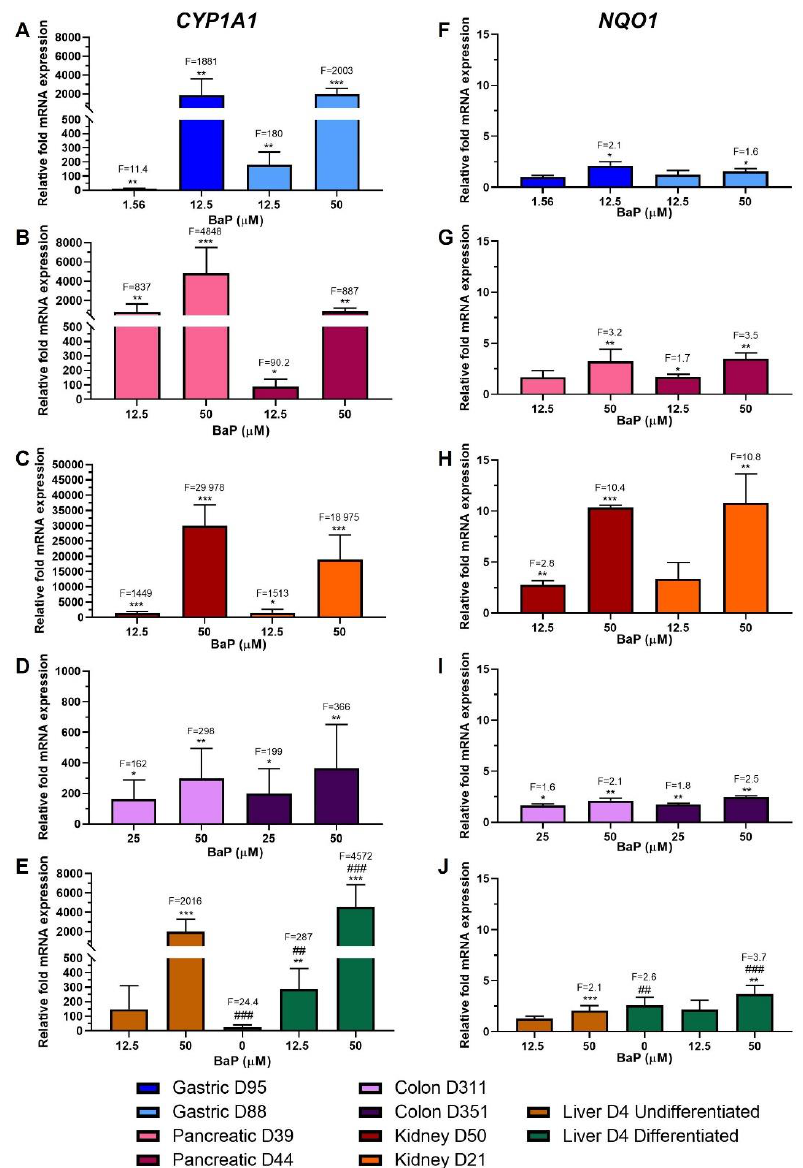
Figure 2. Relative gene expression of XMEs in human tissue organoids after BaP treatment. RT-qPCR and the 2 −ΔΔCT method were used to determine CYP1A1 and NQO1 expression in gastric (D95 and D88; ( A , F )), pancreatic (D39 and D44; ( B , G )), kidney (D50 and D21; ( C , H ), colon (D311 and D351; ( D , I )) and liver undifferentiated and differentiated (D4; ( E , J )) organoids treated with the indicated BaP concentrations for 48 h. Values were normalised to mRNA expression of the house- keeping gene GAPDH and are relative to the vehicle control (0.5% DMSO); for liver organoids the values are relative to the undifferentiated control. Results are shown as mean ± SD (n ≥ 3). Statistical analysis was performed by log2 transforming the data and a one sample t-test with Bonferroni correc- tion against the control mean of 0: * p < 0.05; ** p < 0.01; *** p < 0.001 compared to untreated control; ## p < 0.01; ### p < 0.001 compared to undifferentiated liver control. CYP1A1 upregulation by BaP was significant in both gastric organoid cultures, with an almost 2000-fold increase at the highest concentrations, and 11.4-fold and 180-fold in- creases for D95 and D88, respectively, at the lowest concentrations (Figure 2A). Pancreatic